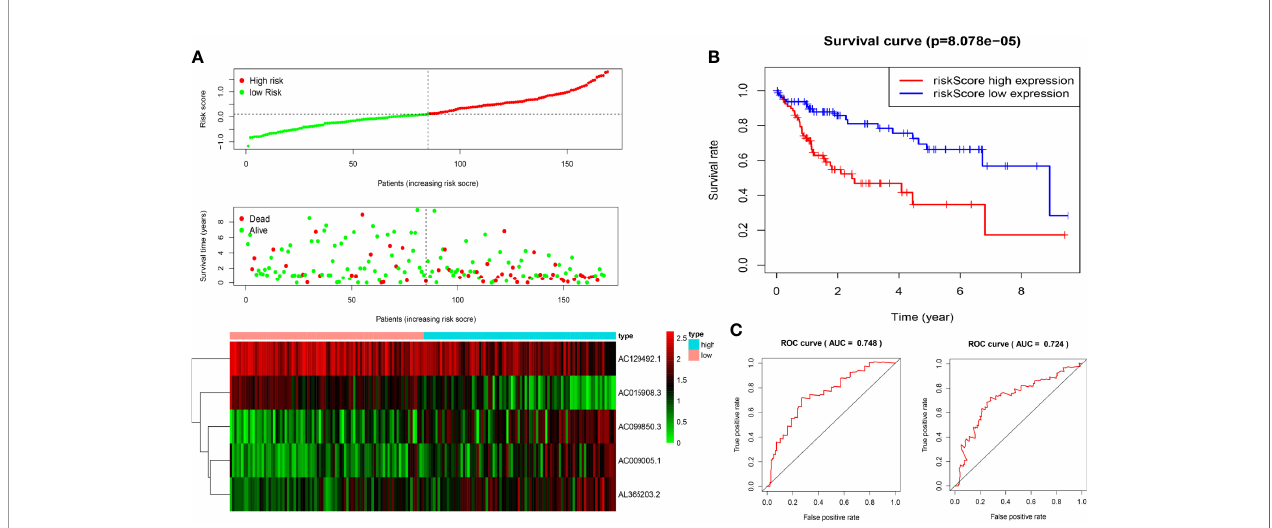
FIGURE 2 | Construction of fi ve-immune-related gene models from the training dataset. (A) Distribution of high-risk and low-risk groups of patients, scattergram of the patients in the two groups, and heat map of the expression of fi ve lncRNAs in HCC. (B) Kaplan-Meier curves for the OS of patients in the high-risk group and low-risk group in the training dataset. (C) The area under the time-dependent ROC curve (AUC) of time-dependent receiver operating characteristic (ROC) curves veri fi ed the prognostic performance of the risk score in the training dataset, and the results showed that the AUC of the model was 0.748 at one year, 0.724 at three years.